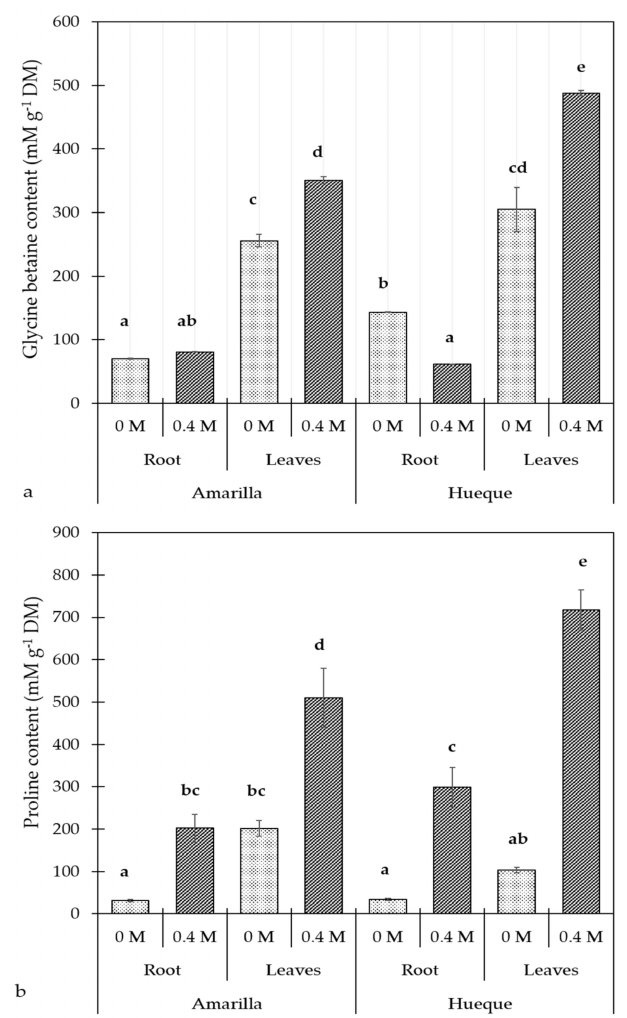
Figure 1. Effect of salinity on glycine betaine ( a ) and proline ( b ) content in the roots and leaves of quinoa plants. Different letters denote significant differences ( p ≤ 0.05). Average values were calculated based on 4 samples per treatment (mean ±